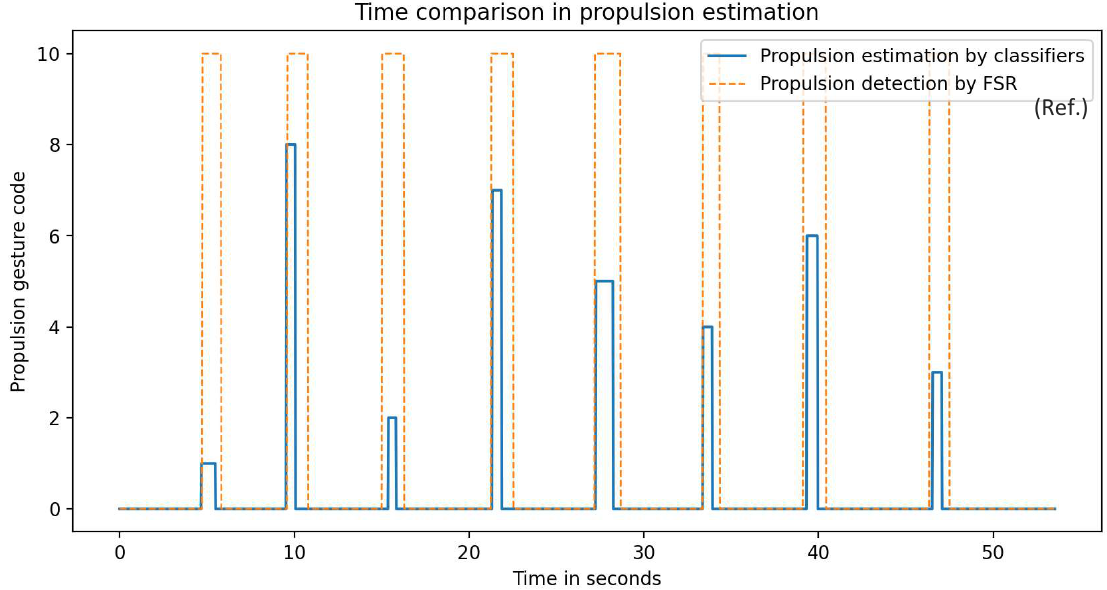
Figure 17. Actual choreography and prediction comparison.